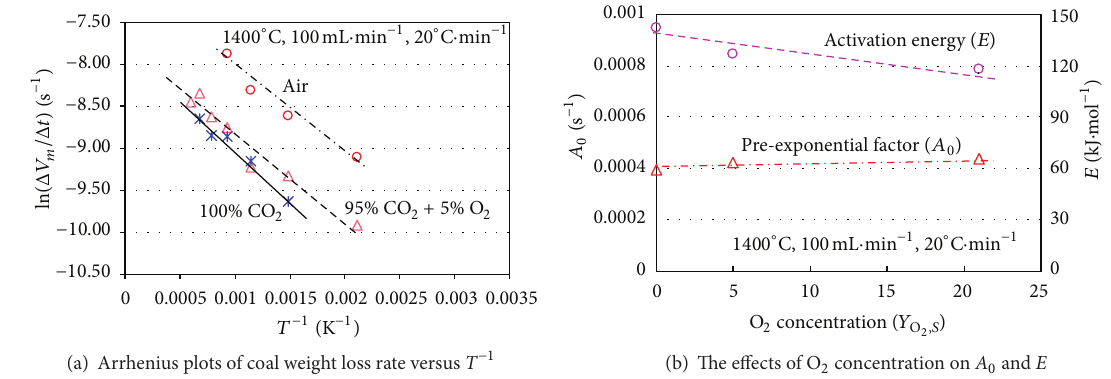
(b) The effects of O 2 concentration on A 0 and E Figure 16: Coal weight loss rates with different temperatures and O 2 concentrations.